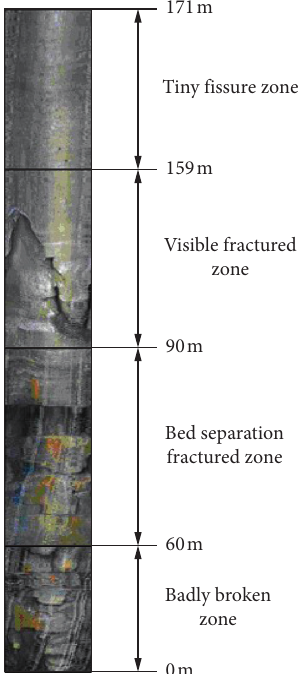
Figure 6: Damage characteristics of the hole wall.